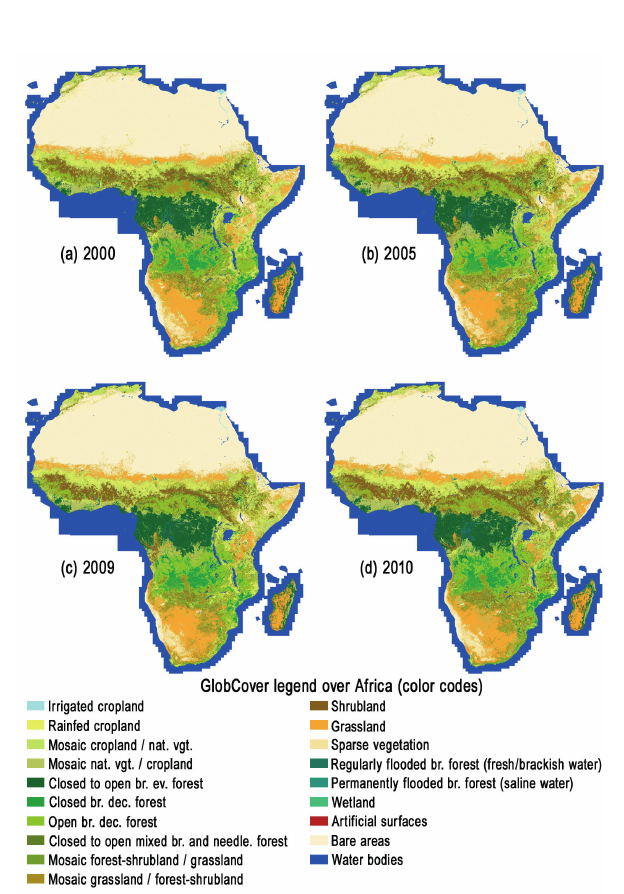
Fig. 5. Land cover products over Africa for the years 2000 (a) , 2005 (b) , 2009 (c) and 2010 (d) , obtained by running the GlobCover clas- sification chain over the corresponding SPOT-Vegetation time se-